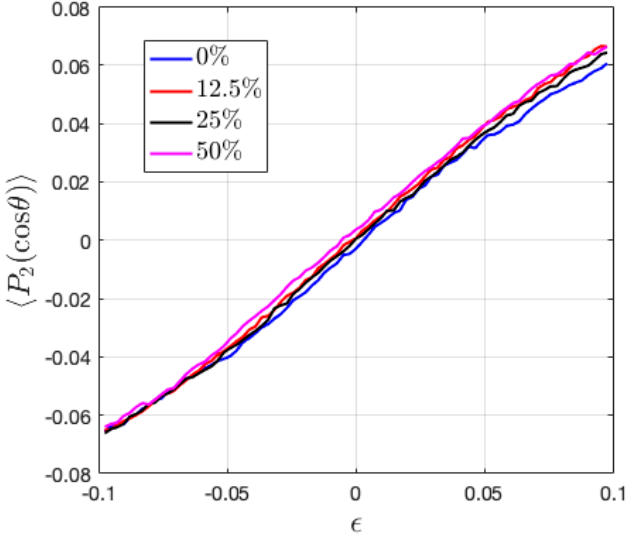
Figure 11. The change of bond orientation during the tension and compression of ionic HPs with varying charge ratio f c , HP